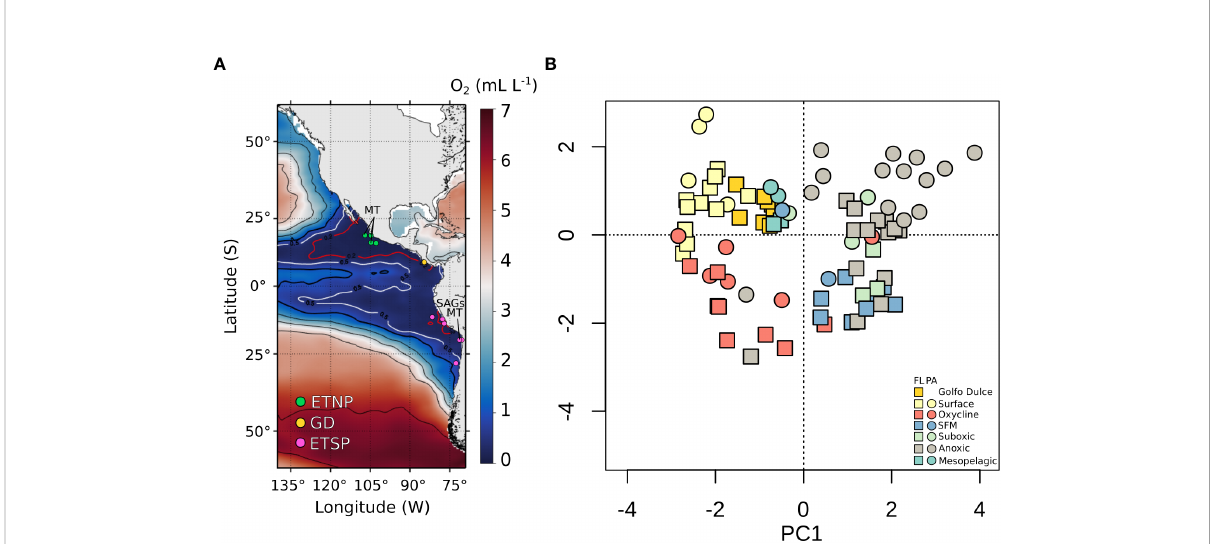
FIGURE 1 Geographic distribution of samples and prokaryotic community structure across OMZs of the Paci fi c Ocean. Geographic and depth distribution of samples across OMZs of the Paci fi c Ocean. (A) Map of the Eastern Paci fi c Ocean showing the stations utilized in this study (white fi lled circles). Colors and the contour lines correspond to the oxygen concentrations in mL L -1 at 325 meters depth (mean depth of the OMZ core, CARS 2009). (B) Principal component analysis of the bacterial community composition according to 16S rRNA gene metabarcoding data. The ASVs counts table was normalized using the variance-stabilizing transformation performed by DESeq. The two principal components were plotted. Samples were colored based on the water chemistry and collection depths. Surface: samples from depths of 0 -~30m; SFM Secondary Fluorescence Maximum; Oxycline: [O 2 ] > 5 uM); Suboxic: [O 2 ] < 5 uM); Anoxic: [O 2 ] < 5 uM, and > 4 µM of Nitrite. ETNP, Eastern Tropical North Paci fi c; GD, Golfo Dulce; ETSP, Eastern Tropical South Paci fi c; FL, Free-Living; PA,